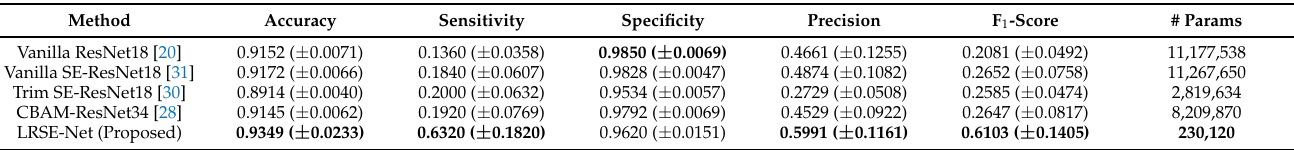
Table 4. Performance comparison on the A-DSSS